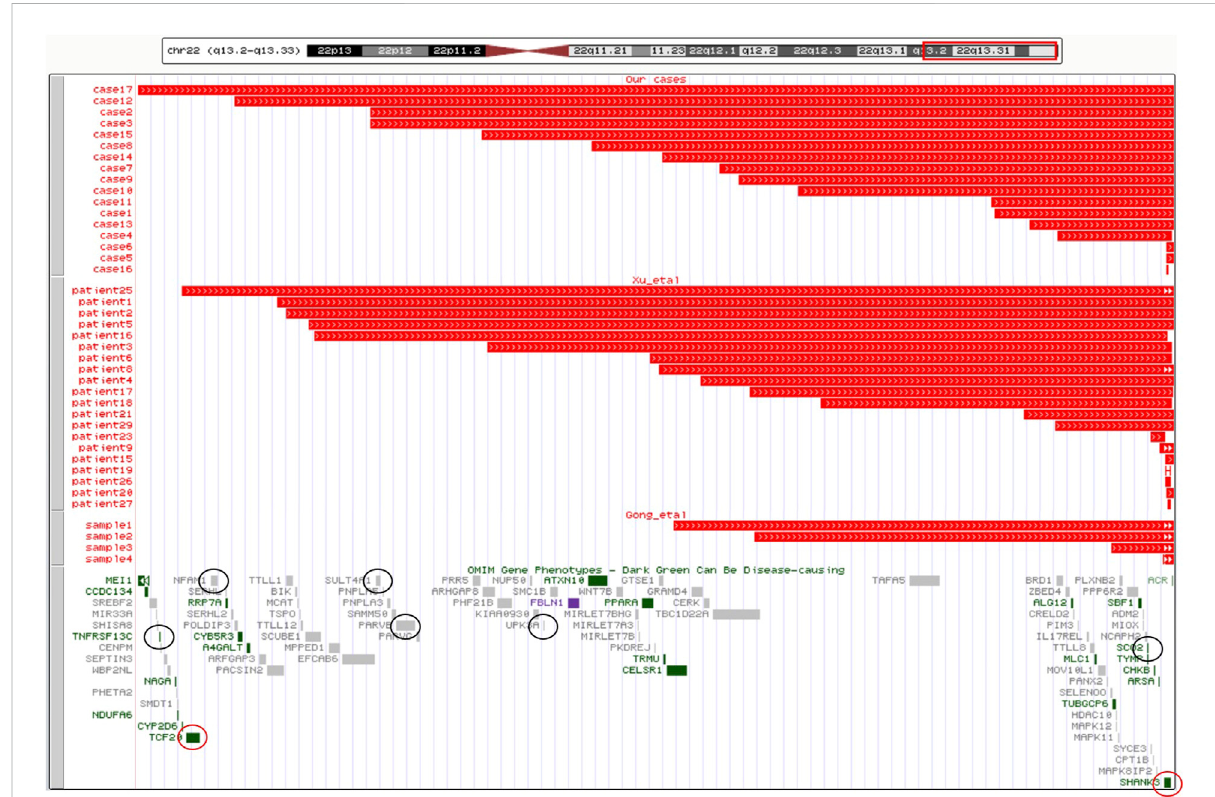
FIGURE 1 Cytogenomic mapping and genotype – phenotype correlations for candidate genes of 22q13.2-q13.33. A cytogenomic map for sizes of deletions and candidate genes of 22q13.2-q13.33. The upper panel shows chromosome 22 with the band location information. The region of 22q13.2-q13.33is boxed inred. The middle panel shows the size and location of the41 deletions: 17cases in ourstudy, 20patients inthe literature of Xuetal.(2020),andfoursamplesintheliteratureofGongetal.(2012).ThelowerpanelshowsOMIMgenesin22q13.2-q13.33.TheHIgenesare circled in red and six other genes associated with the PMS phenotype are circled in black.